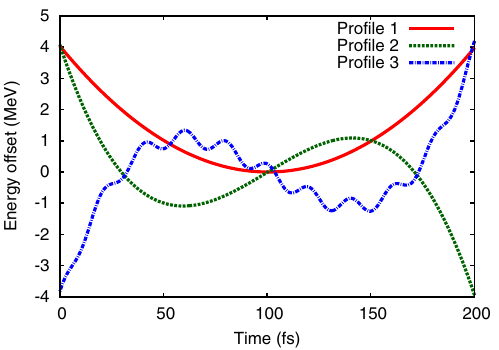
FIG. 4. Longitudinal beam profiles used in simulations of harmonic generation schemes.